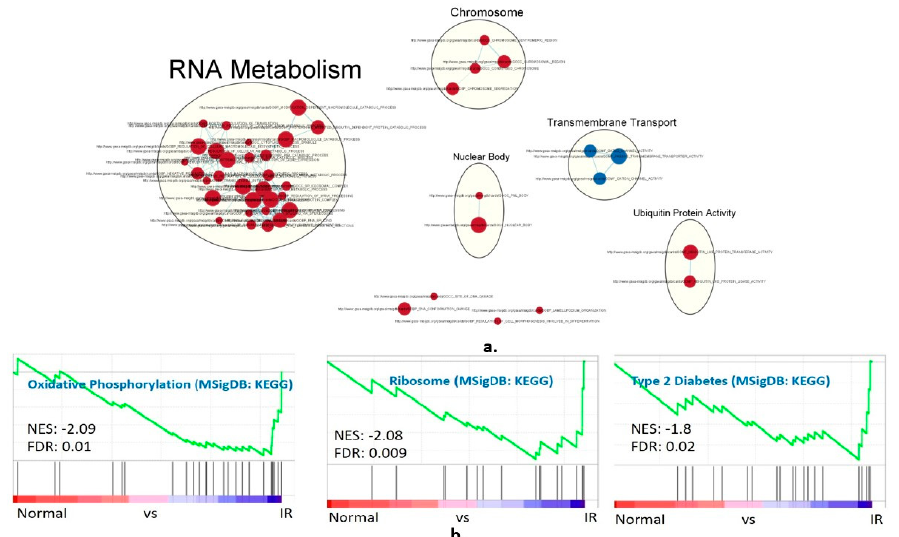
Figure 1. Enrichment analysis of ( a ) IR metagenes using Z-scores of the meta-analysis and Gene Ontology (GO) gene sets. ( b ) GSEA analysis of IR metagenes using KEGG in the Molecular Signatures Database (MSigDB). NES, normalized enrichment score; FDR, false discovery rate.